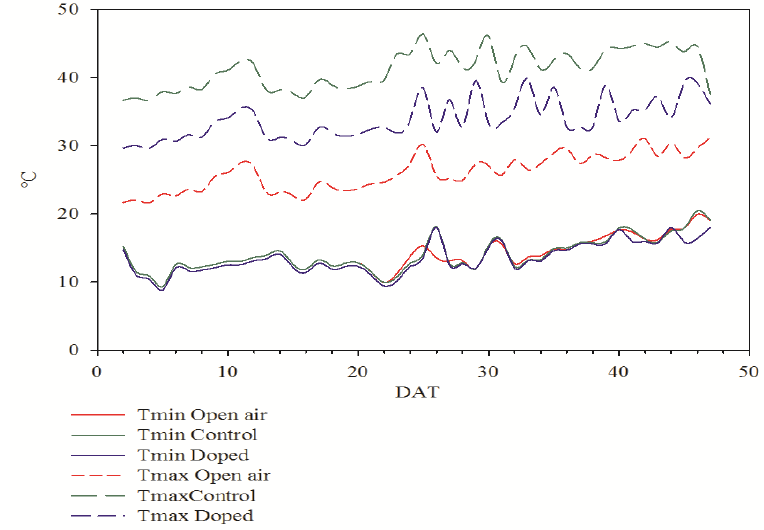
Figure 1. Trend of minimum and maximum air temperatures during the growing period under doped (blue lines), control (green lines), and in open-air (red lines) conditions; DAT: day after transplant.